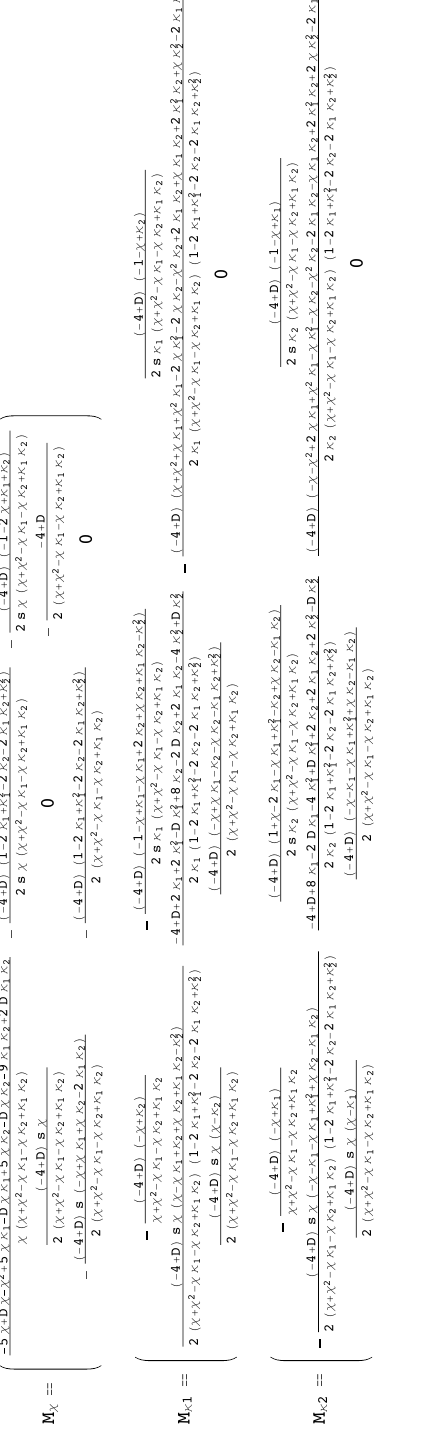
Figure 11 . Matrices for the (cid:15) -form di(cid:11)erential equations on the maximal cut for the double box with two adjacent massive legs.